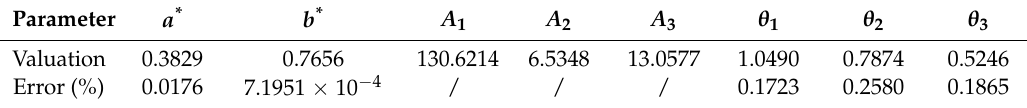
Table 3. Parameter identification and errors of the oblique envelope signal.